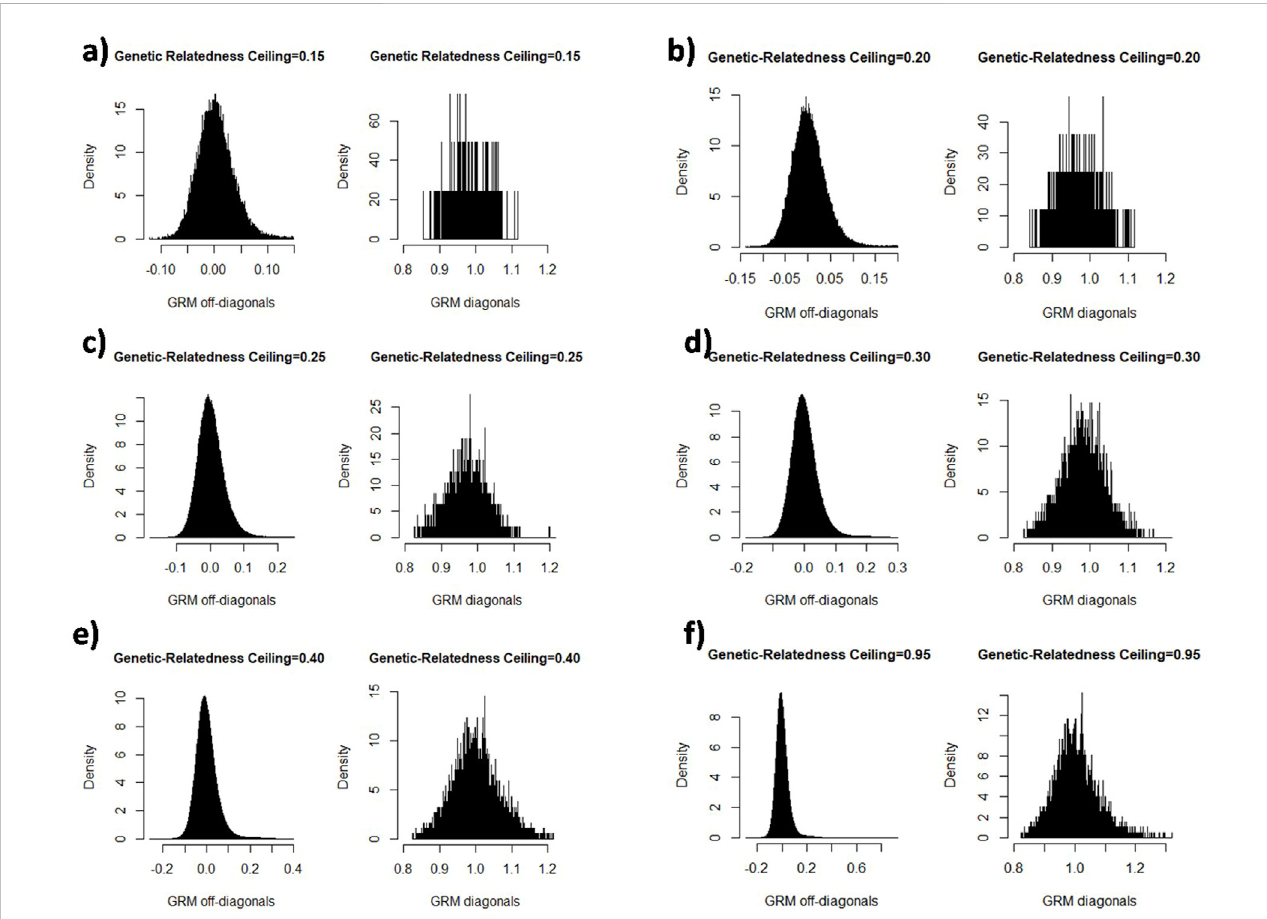
FIGURE 1 Theillustrationofthediagonalandoff-diagonalelementsofgenomicrelationshipmatrixinthecut-offrelatednessdifferentvalues:0.15 (a) ,0.20 (b) ,0.25